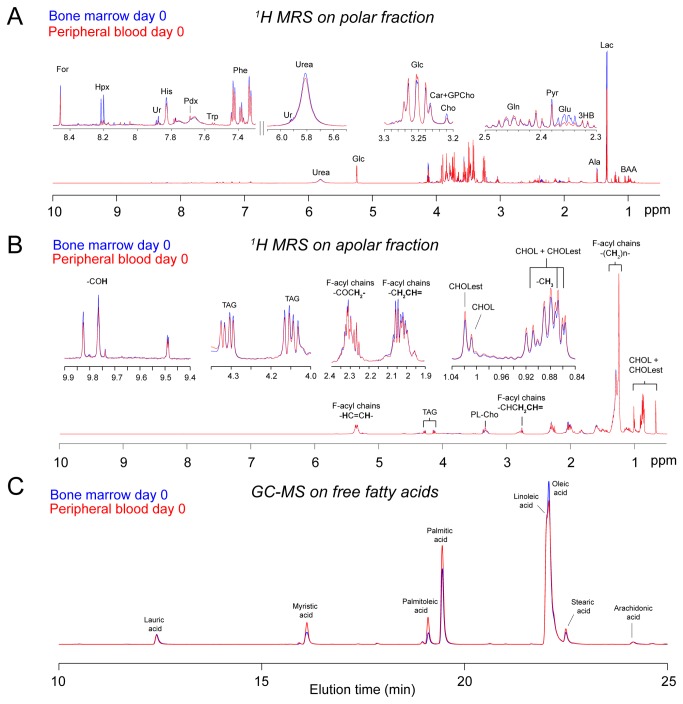
1H-MRS and GC-MS metabolic profiles of bone marrow and peripheral blood samples at the time of ALL diagnosis.Representative spectra of BM (blue line) and PB (red line) specimens. Spectra were acquired from (A) 1H-MRS analysis of filtered polar fractions, (B) 1H-MRS analysis of recovered whole lipid fractions, and (C) GC-MS analysis of FFA extracts. Metabolites with the greatest difference between BM and PB are labeled and include alanine (Ala), free cholesterol (CHOL), cholesterol esters (CHOLest), choline (Cho), formate (For), glucose (Glc), glutamate (Glu), glutamine (Gln), lactate (Lac), histidine (His), hypoxanthine (Hpx), palmitic acid, oleic acid, triacylglyceride (TAG), and uridine (Ur). Other abbreviations used are: (2HB), 2-hydroxybutyrate; (3HB), 3-hydroxybutyrate; (2Og), 2oxo-glutarate; (2Oic), 2oxo-isocaproate; (BAA), branched amino acids; (Car), carnitine; (Cho), choline; (CHOL), free cholesterol, (CHOLest), cholesterol esters; (For), formate; (Fum), fumarate; (Glyc), glycerol; (GPCho), glycero-3-phosphocholine; (Hpx), hypoxanthine; (Lac), lactate; (Niac), niacinamide; (Pglu), pyroglutamate; (Pyr), pyruvate; (Ur), uridine; (Pdx), pyridoxine; (TAG), triacylglyceride; (T-Chol), total cholesterol.